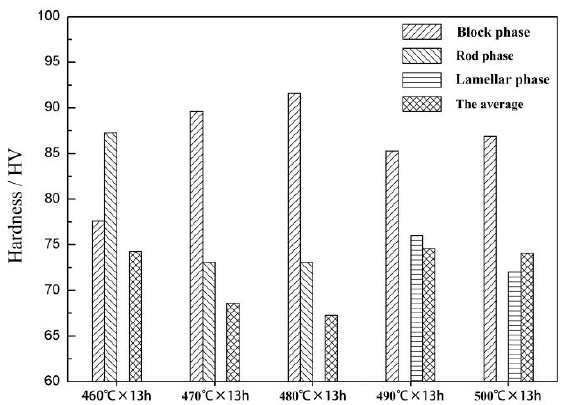
Figure 4. The hardness of block phase, rod phase, lamellar phase, and the average hardness of the alloy after different solution treatments.